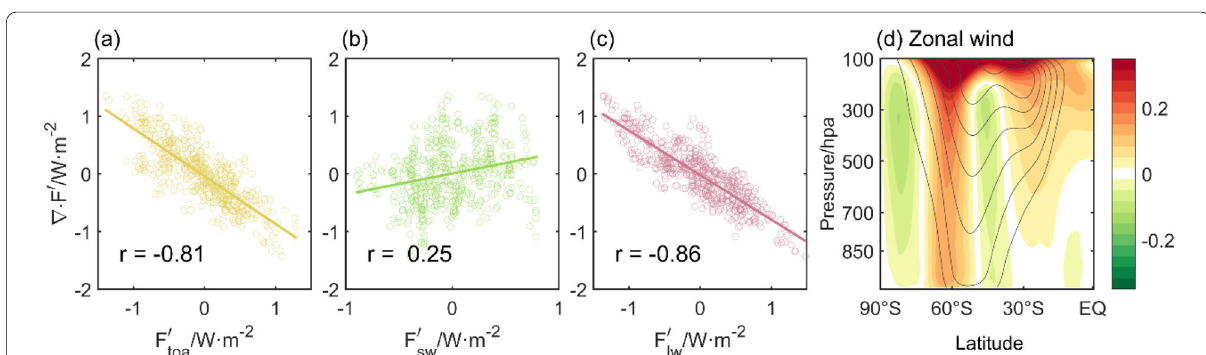
Fig. 6 Linear regression of a OD-induced TOA heat flux ( F ′ TOA ) and its components of b shortwave ( F ′ SW ) and (c) longwave ( F ′ LW ) onto atmospheric energy convergence ( ∇ · F ′ ) in the Antarctic (60°–90° S) during 1955–2000. Lines are a least-squares linear fit to the data, r is the correlation coefficient, and all of the flux variables are filtered with a 12-month running mean. d Zonal mean wind climatology from the historical simulation (contours) and its change due to OD (color) in the Southern